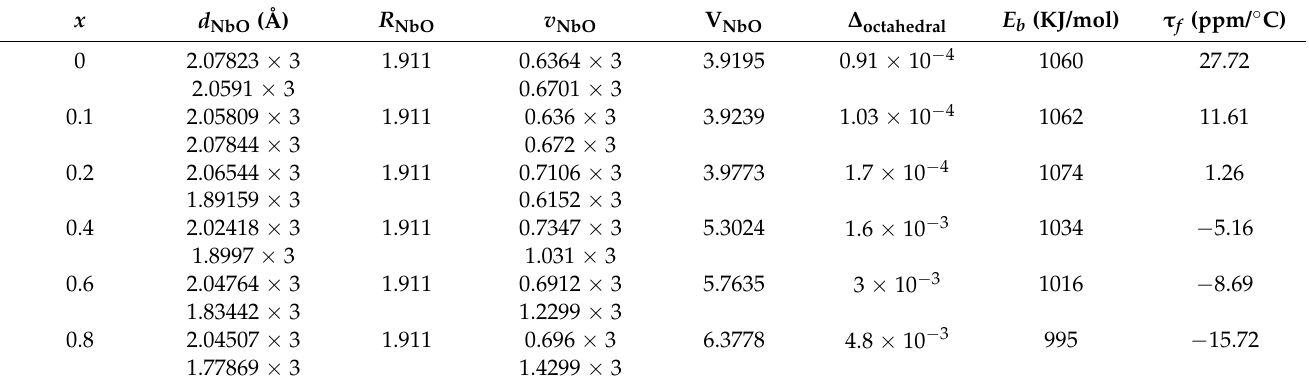
Table 5. Bond length, octahedral distortion, bond energy, and τ f value of Ba 1 − x Sr x (Zn 1/3 Nb 2/3 )O 3